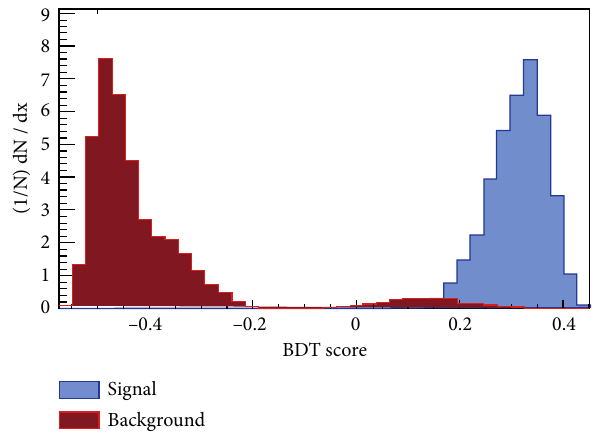
Figure 19: By employing an appropriate cut, it is achievable to distinguish the signal from the background with great e ffi ciency. (The curve was determined by analyzing η